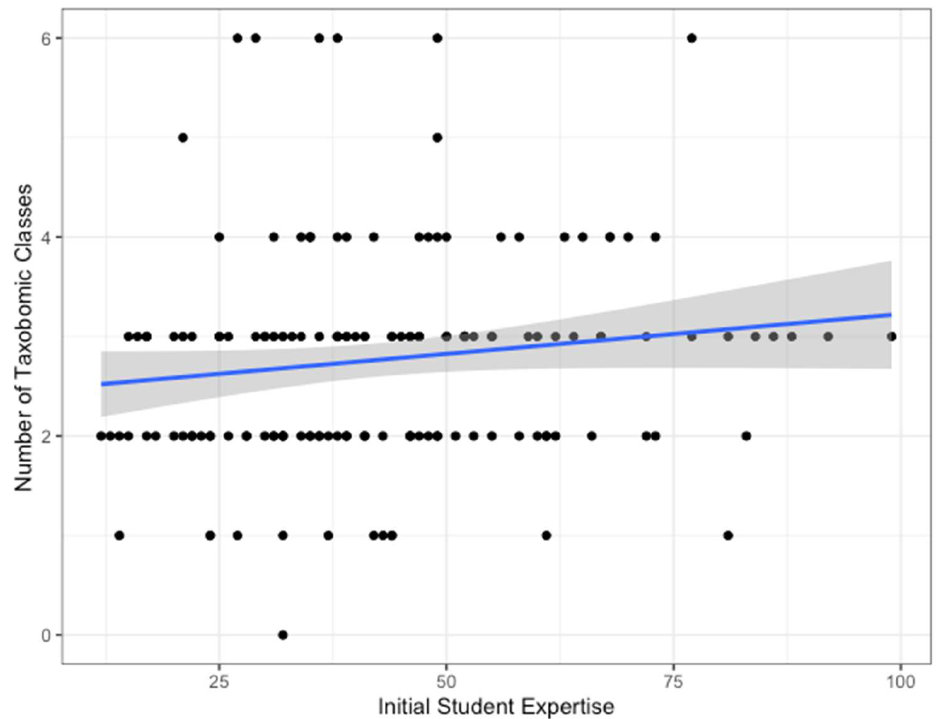
Figure 3. Initial student expertise (total expertise score) had a small but significant effect on the number of taxonomic classes represented in their list of examples given for the “force” assignment. The blue line represents a linear model fit to the data (R 2 = 0.012) with the standard error in gray. Analyses presented in the text are from a Spearman rank correlation test.